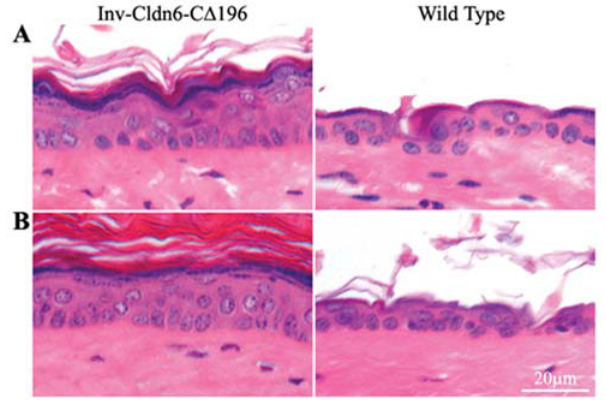
Figure 4. Histological evidence of epidermal abnormalities in the aging Inv-Cldn6-C D 196 transgenic epidermis. Histological evidence of epidermal abnormalities emerged in aging Inv-Cldn6- C D 196 transgenic mice after 3 ( A ) and 6 ( B ) months as compared to the wild type. These included an expanded stratum corneum, as well as an expanded suprabasal zone and a less compacted granular layer suggesting an intrinsic propensity for injury and inefficient repair that increases with aging in the Inv-Cldn6-C D 196 epidermis.